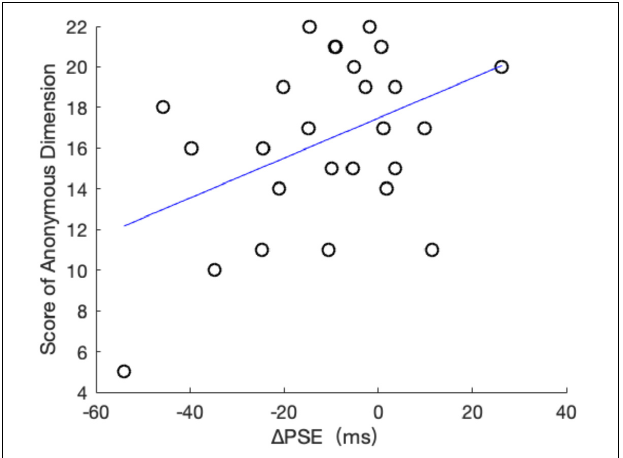
FIGURE 3 | The scatter diagram between the (cid:49) PSE and the score of anonymous dimensions from